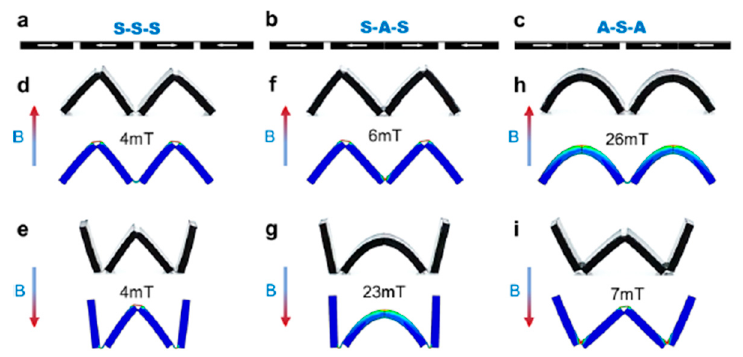
Figure 11. A combination of symmetric (S) and asymmetric (A) joints [49]. ( a ) S − S − S ( b ) S − A − S ( c ) A − S − A. ( d – i ) Simulated deformations for the joint types in ( a – c ) with positive ( d , f , h ) and negative ( e , g , i ) magnetic field.